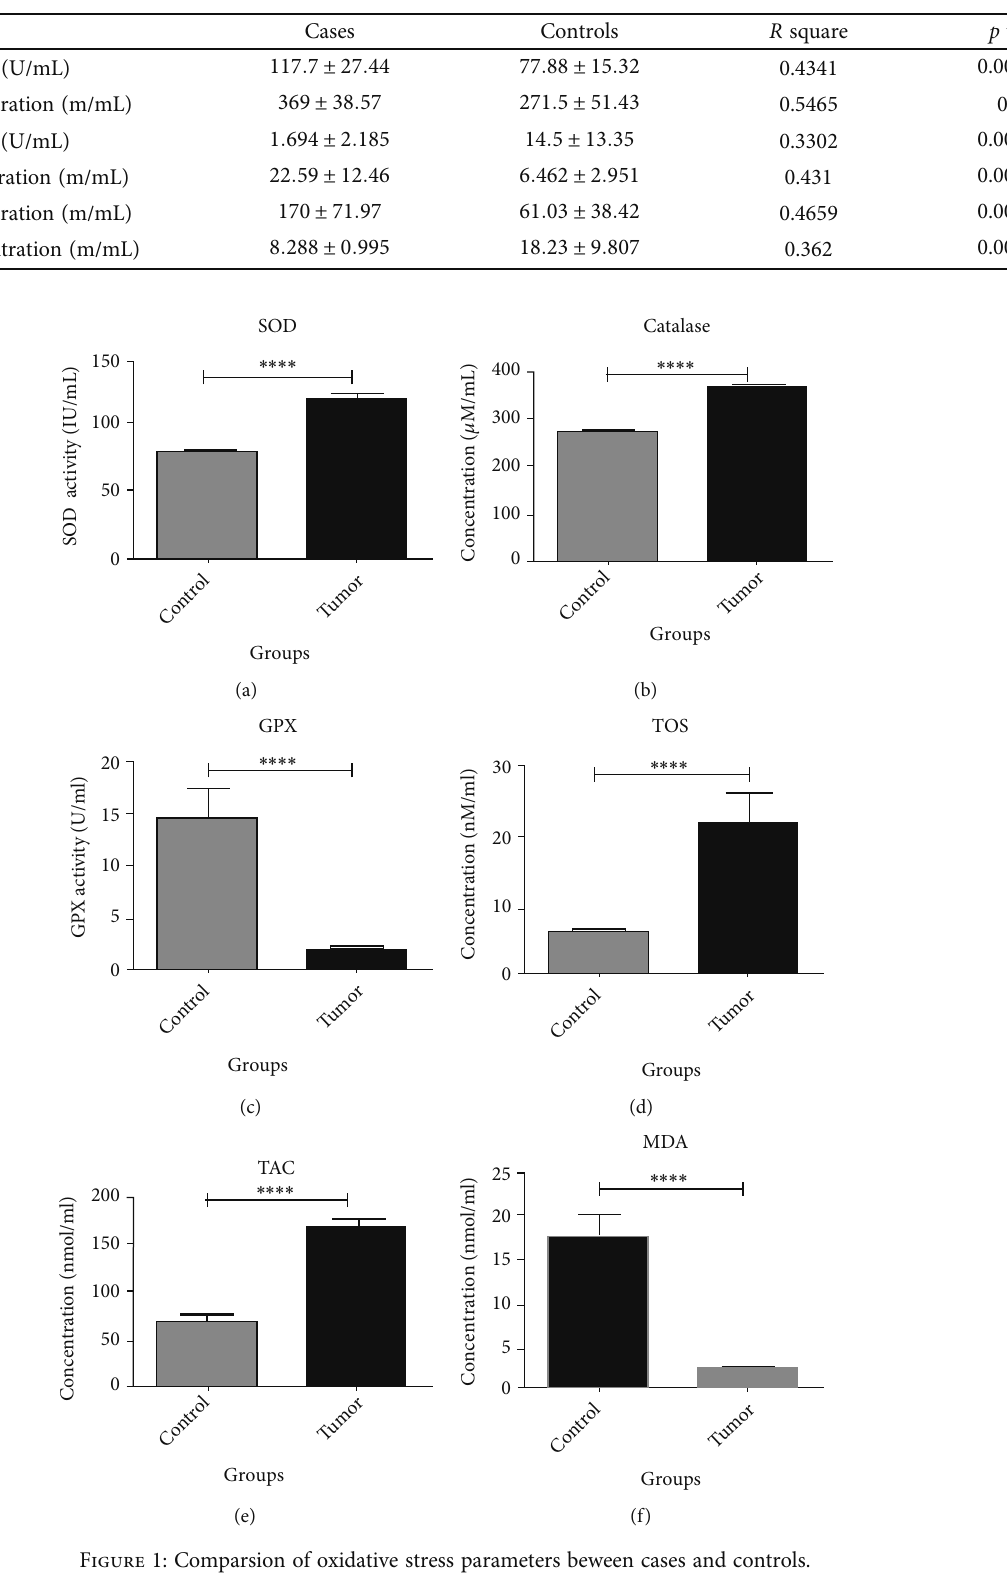
Table 4: Comparison oxidative stress parameters between cases and controls.